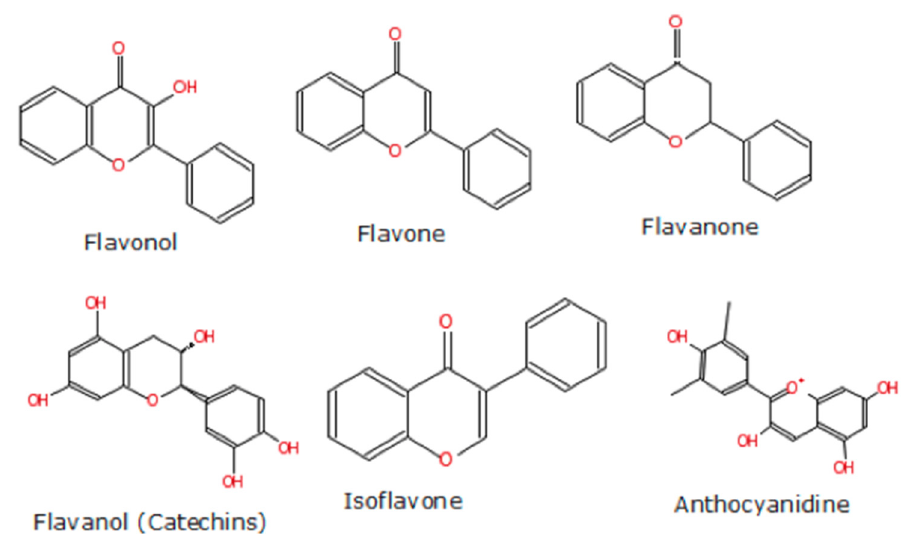
Figure 4. Major types of flavonoids (chemical structures produced via the eMolecules platform developed by eMolecules Inc., La Jolla, CA, USA).